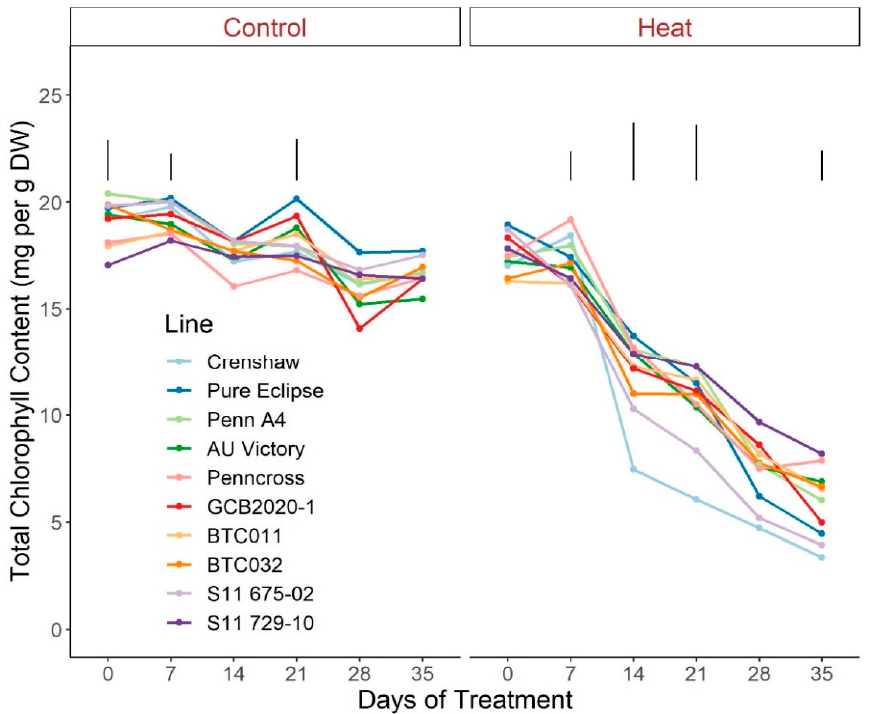
Figure 3. Change in total chlorophyll content for creeping bentgrass lines over time under control (20/15 °C day/night) and heat stress (38/33 °C day/night) conditions. Bars represent LSD values at p = 0.05 on days when significant differences among lines were found. DW, dry weight.